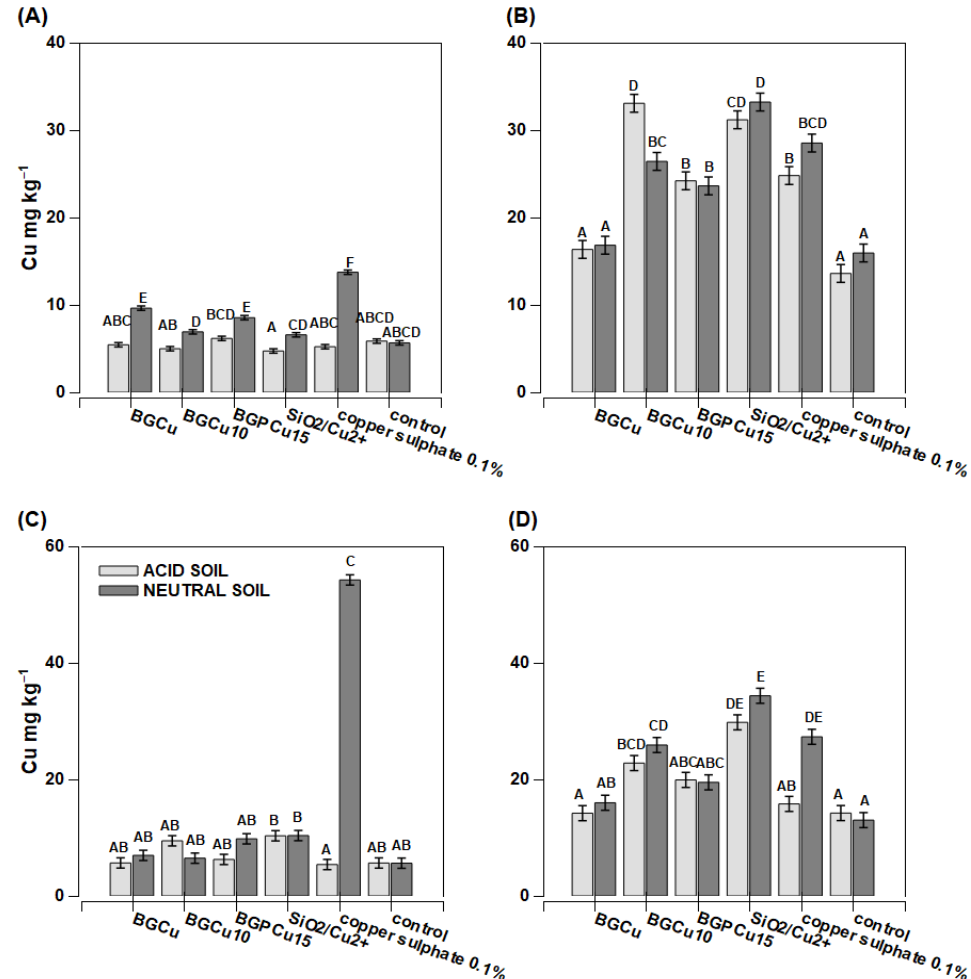
Figure 7. Copper concentration in maize (Zea mays) plant parts after foliar application of fertilizer. Grey bars for acid, dark grey for neutral soil Bars marked with the same letters represent homogenous groups after Tukey’s test at p < 0.05 and error bars represent standard error (n = 4). ( A ) In whole plant—preparation applied on one leaf; ( B ) in one leaf sprayed; ( C ) in whole plant sprayed; ( D ) in leaf cut from whole sprayed plant.